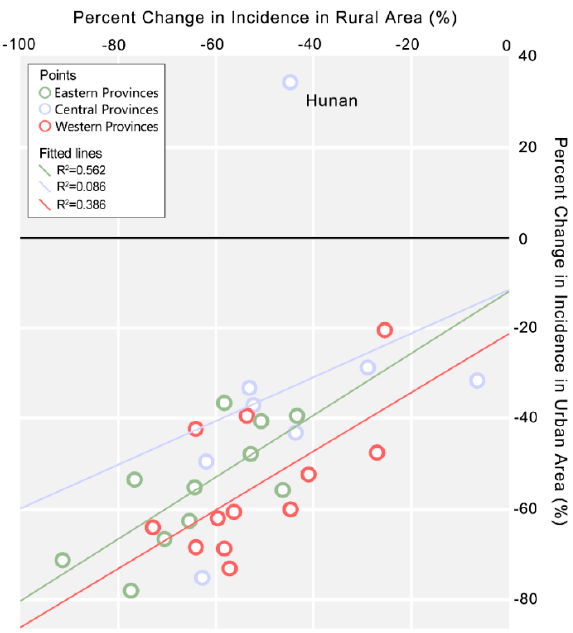
Figure 4. Percent change of bacillary dysentery incidence in urban and rural areas by province. Exact incidence and change of incidence in urban and rural area of each province during 2005–2010 is shown in Figure